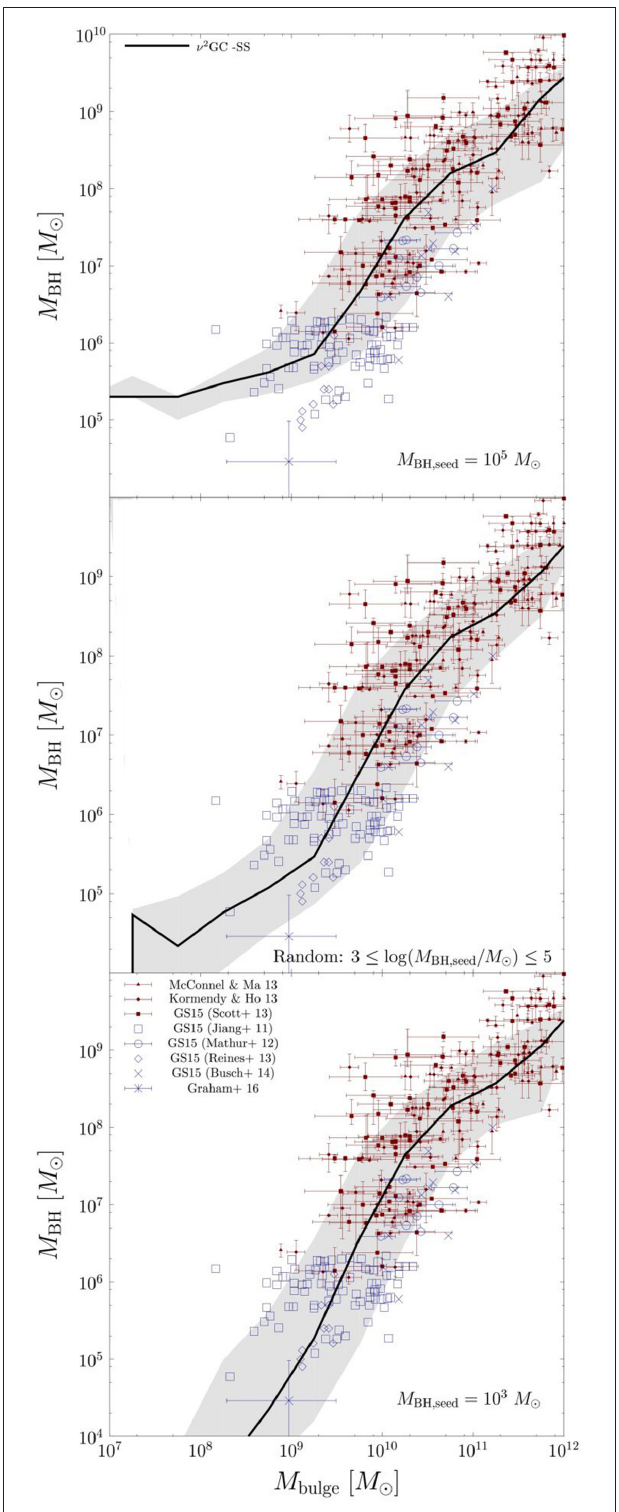
FIGURE 1 | M BH – M bulge relations at z ∼ 0 for different M BH,seed ; the massive (top) , random (middle) , and light (bottom) seed models. Black